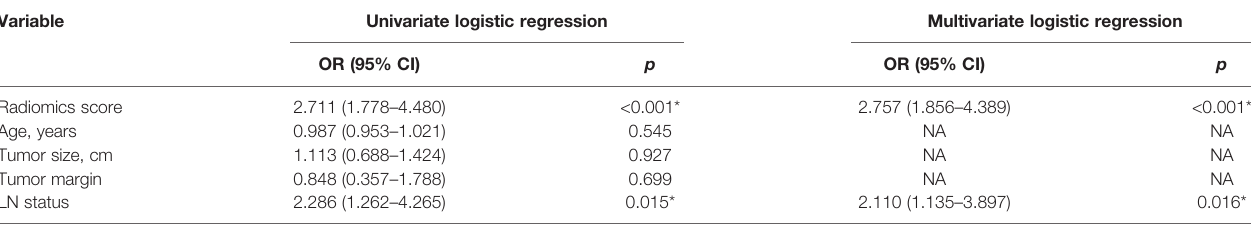
TABLE 2 | Risk factors for ALN metastasis in breast